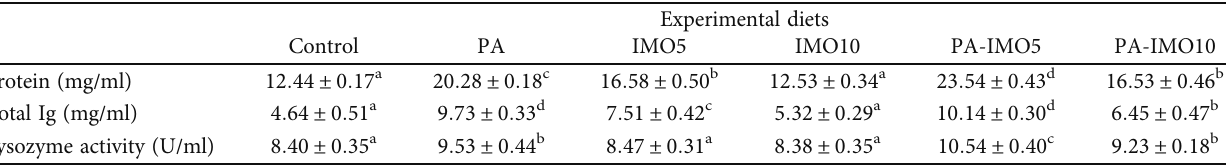
Table 4: Mucosal immune parameters of common carp fed di ff erent levels of Pediococcus acidilactici (PA) and isomaltooligosaccharide (IMO) after 8